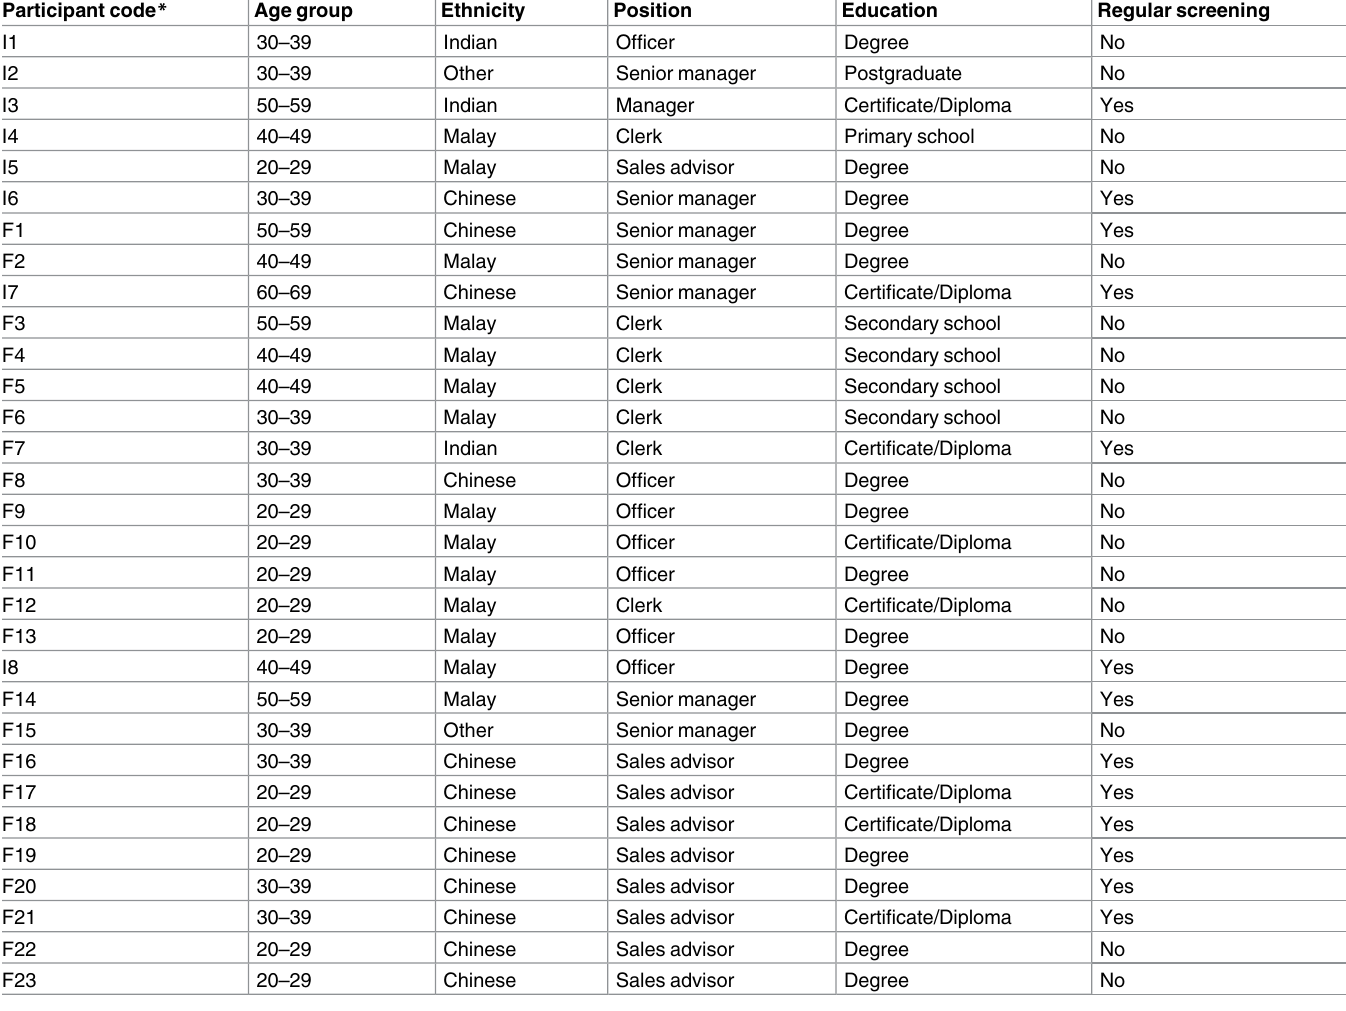
Table 2. Participant code and characteristic.